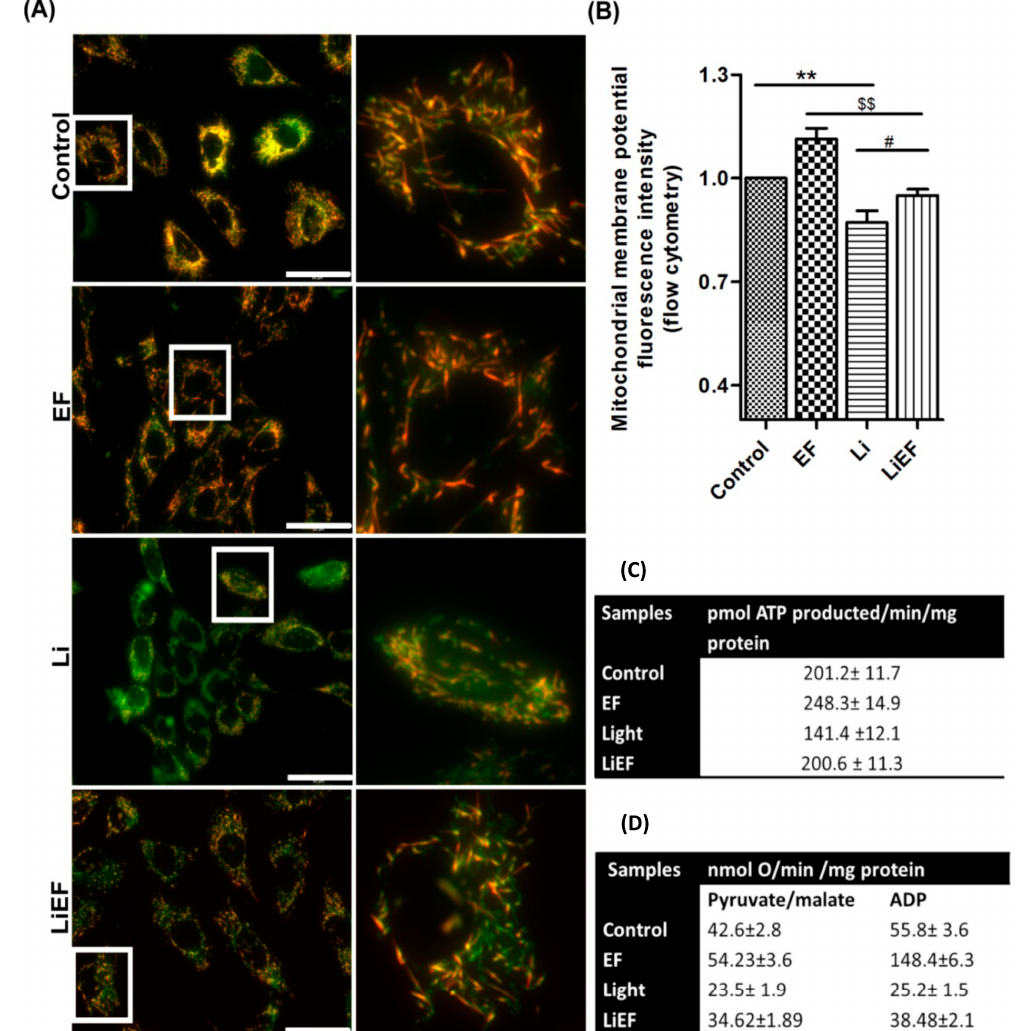
Figure 3. Gain in mitochondrial membrane potential, oxygen consumption and ATP production in irradiated cells due to EF stimulation. ( A ) Representative images of JC-1 dye during different treated conditions at 0 h time point (Scale bar = 50 µm) and enlarged picture of the marked cells. ( B ) Quantified mean fluorescence intensity ratio of aggregate (red color in ( A )) to monomer (green color in ( A )) JC-1 form measured using FACS analysis (number of cells in triplicates for flow cytometry = 10,000 cells; 3 independent experiments; mean ± S.E.M.; ** p < 0.01 w.r.t Control, $$ p < 0.01 w.r.t EF, # p < 0.05 w.r.t Li; One way-ANOVA followed by Bonferroni’s test). ( C ) Mitochondrial oxygen consumption was assessed in coupled condition using an amperometric electrode. It reports a representative data of the oxygen consumption at 0 h after addition of 5 mM Pyruvate, 2.5 mM Malate and 0.3 mM ADP to stimulate the process. Irradiated cells displayed decreased mitochondrial respiration, while EF rescued the mitochondrial respiration levels as in control samples. (Number of experiments = 3; mean ± S.E.M.). ( D ) ATP production was assessed using luciferin/luciferase chemiluminescent method at 0 h. In the presence of 5 mM Pyruvate and 2.5 mM Malate as substrates, irradiated cells displayed an inhibition of ATP synthesis by 30%, while EF rescued the ATP synthesis levels as in the control samples. (Number of independent experiments = 3; mean ± S.E.M.).